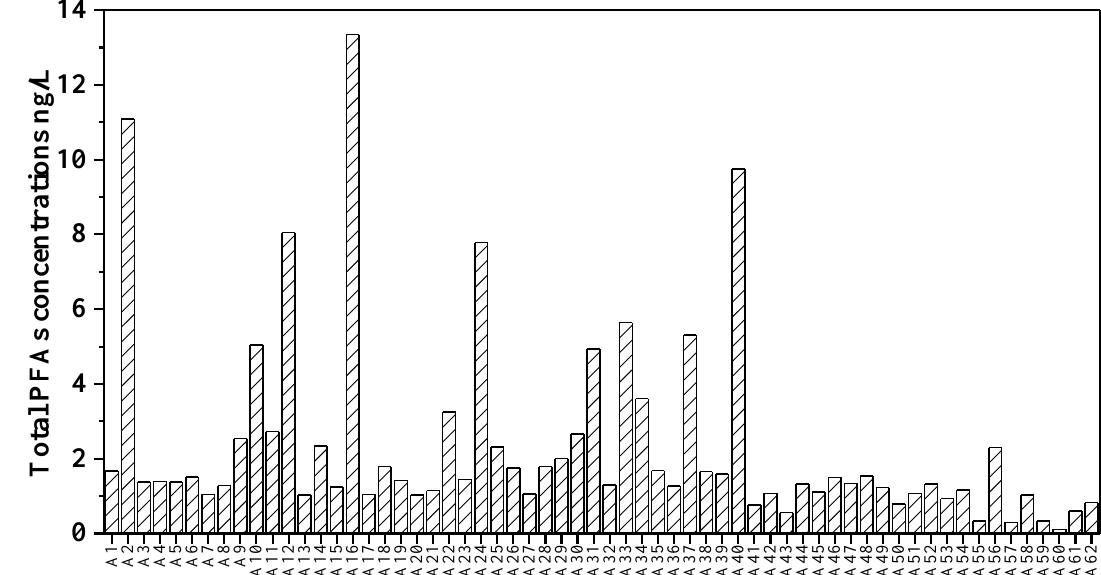
Figure 2. Total concentration of the 10 studied PFAS compounds (ng / L) in 62 groundwater samples in the APPHR in Shijiazhuang City.